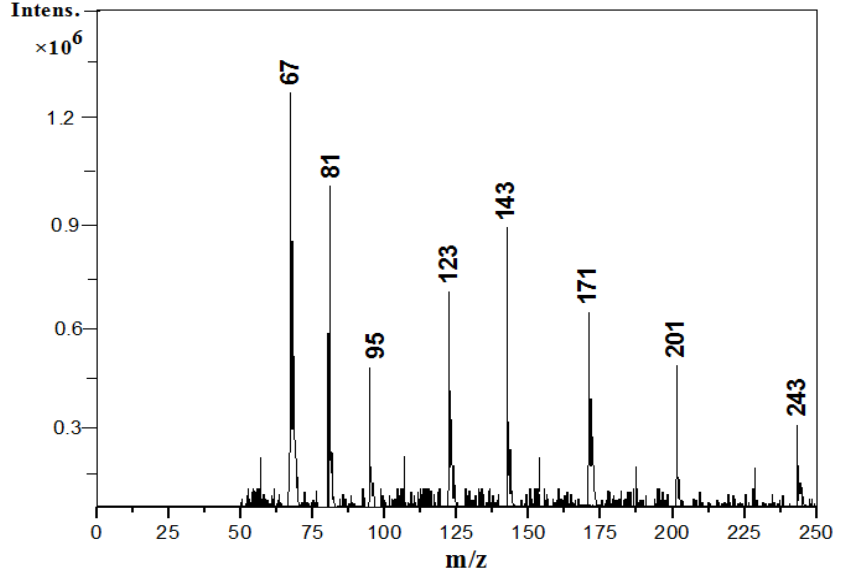
Figure 9. Negative mass spectrum of SOA formed in presence of 300 µ g / m 3 (NH 4 ) 2 SO 4 seed.